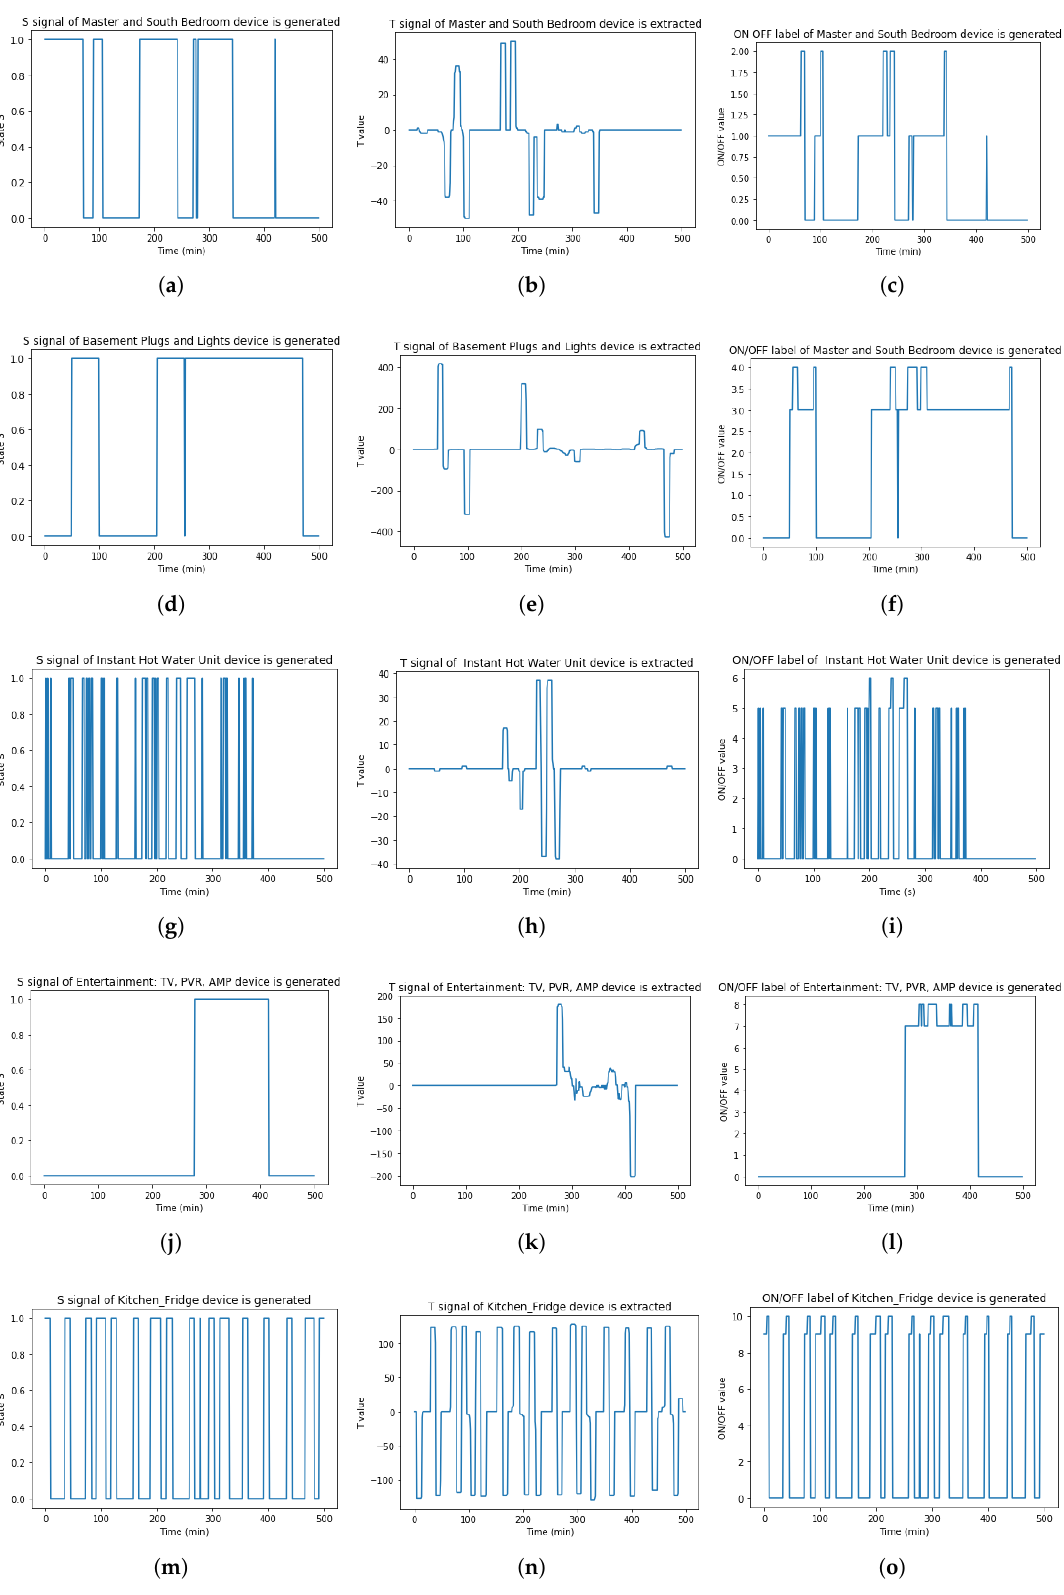
Figure 18. State S , T & ON/OFF label signals of 5 appliances: ( a – c ) Master and South Bedroom device; ( d – f ) Basement Plugs and Lights device; ( g – i ) Instant Hot Water Unit device; ( j )– l ) Entertainment: TV, PVR, AMP device; ( m – o ) Kitchen Fridge